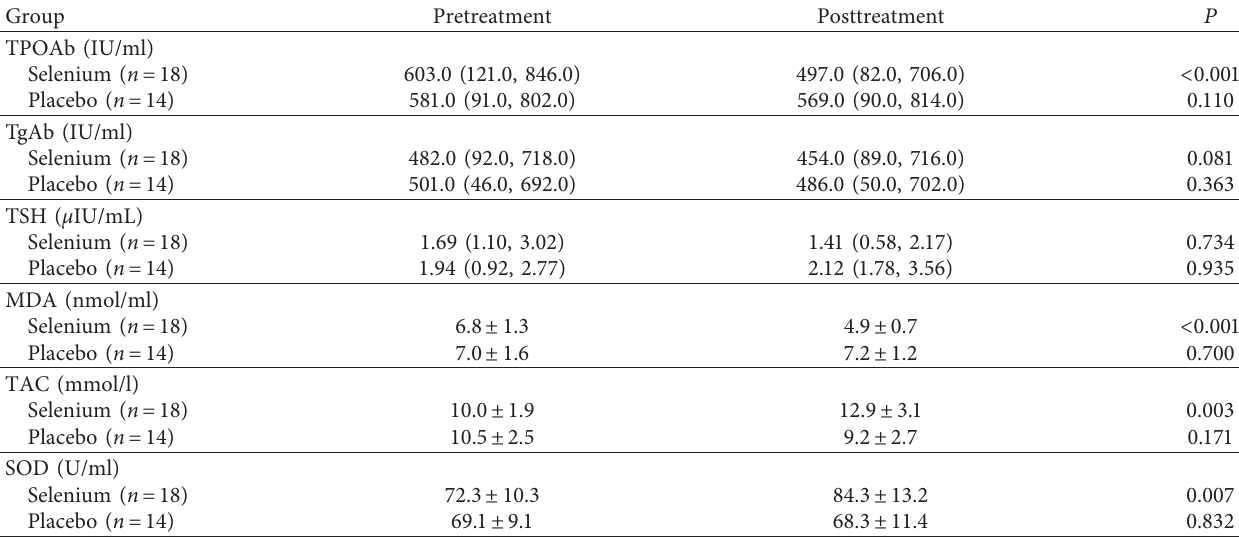
Table 3: Comparison of thyroid autoantibodies and oxidative stress markers before and after treatment within each group.